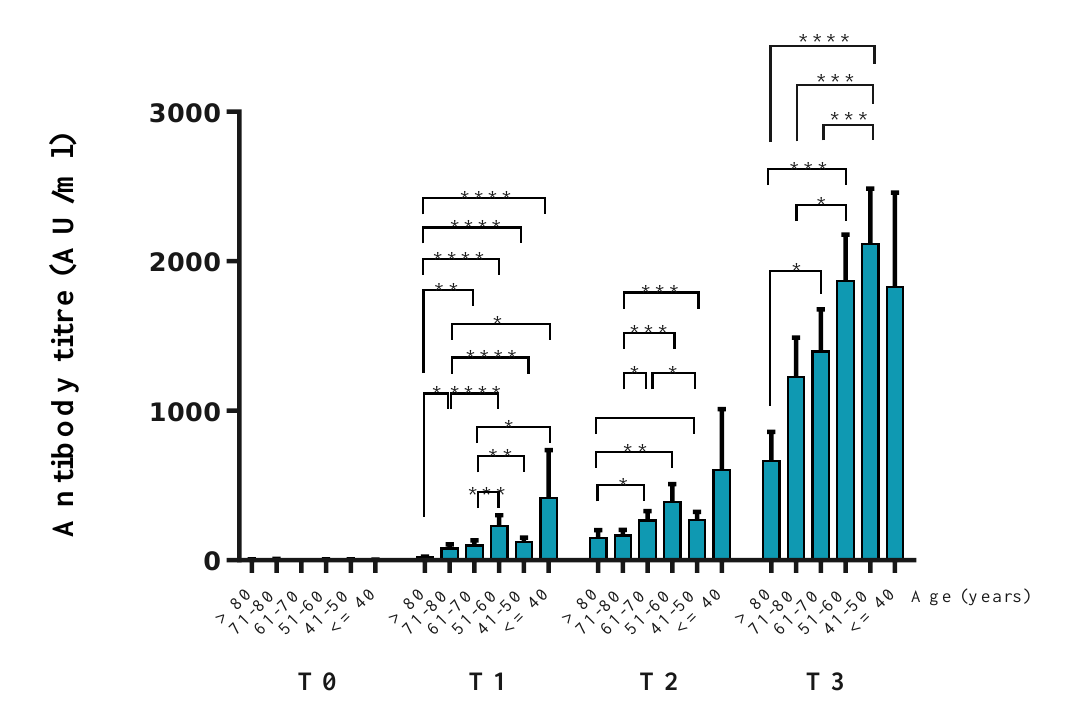
Figure 2 . Anti-RBD antibody levels at the four-time points in the six age groups. * p < 0.05, ** p < 0.01, *** p < 0.005, **** p < 0.001.